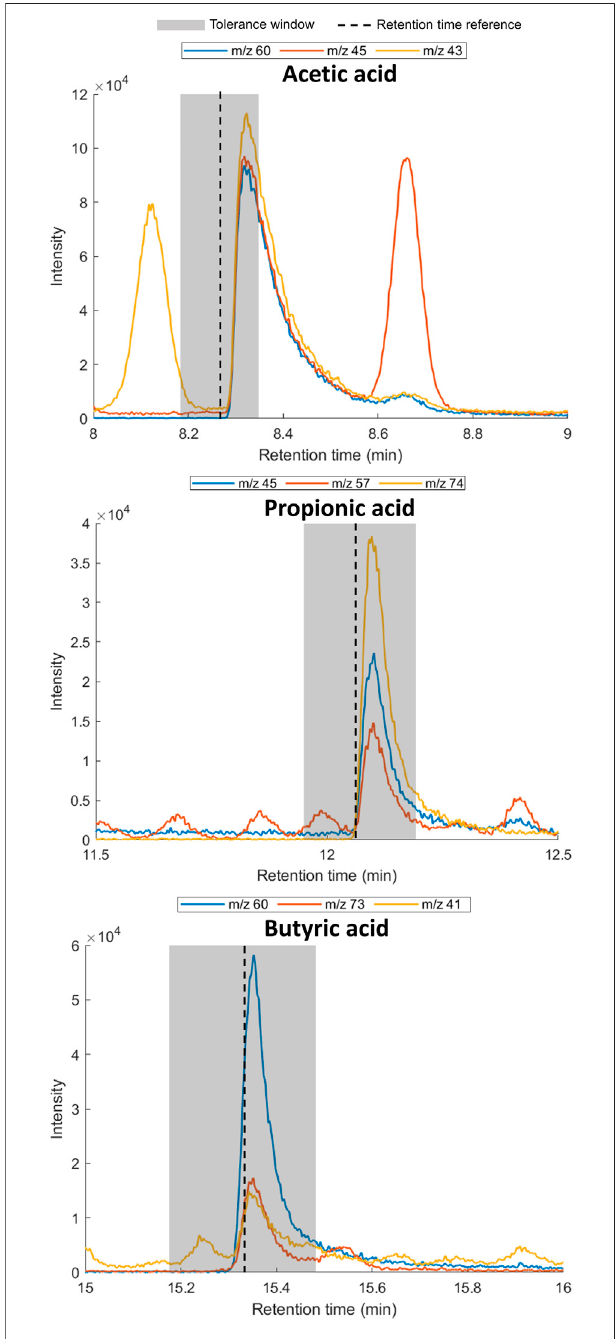
FIGURE 3 | Extracted ion chromatograms for diagnostic ions for acetic acid (left), propionic acid (middle) and butyric acid (right) in exhaled breath. Shadedareaindicatesof1%retentiontimetolerancewindowcalculatedusing reference standards. The retention time of the reference standard and SCFA in exhaled breath can differ due to the effect of the